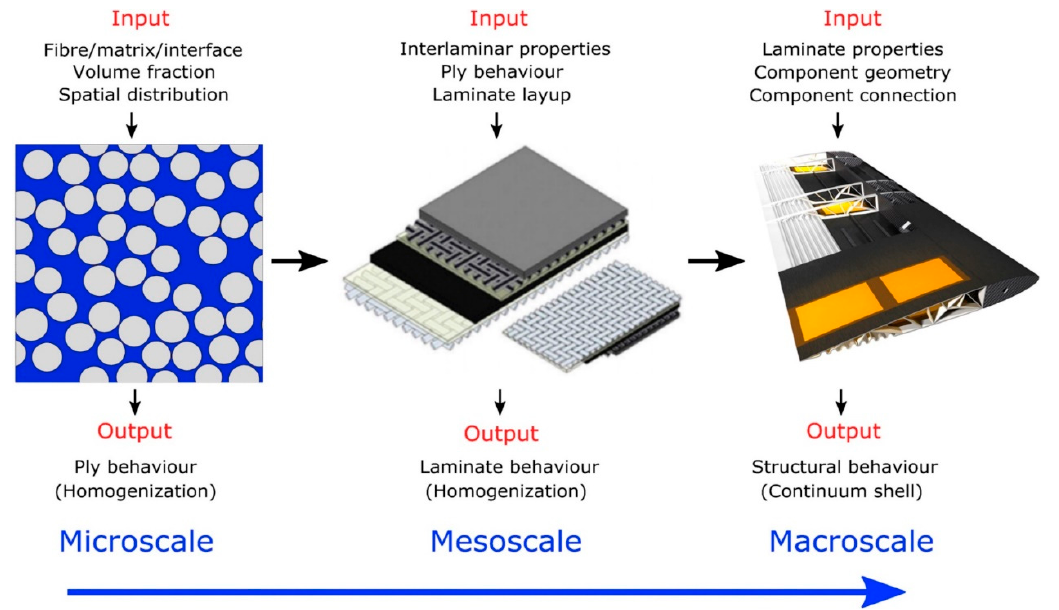
Figure 3. From the microscale to the macroscale. Reproduced with permission [33].